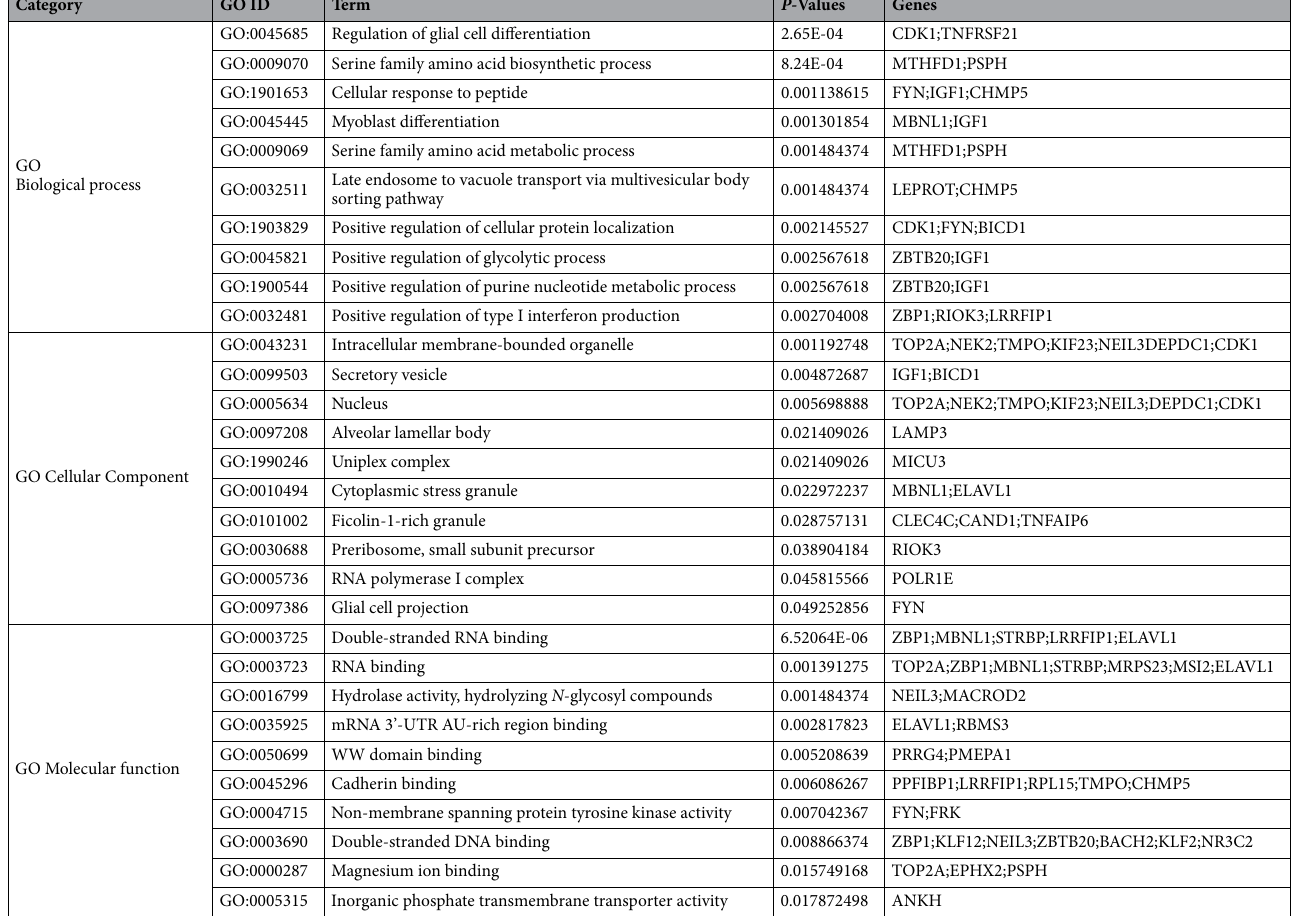
Table 2. Ontological analysis of shared DEGs between EBV, SLE, and